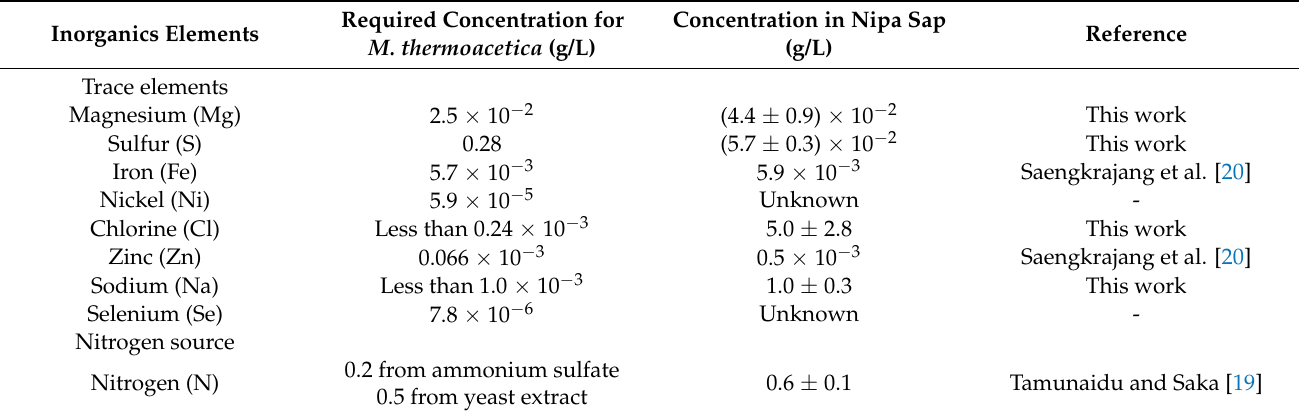
Table 3. Concentration of inorganics elements required for M. thermoacetica in full nutrient condition compared with their amount in nipa